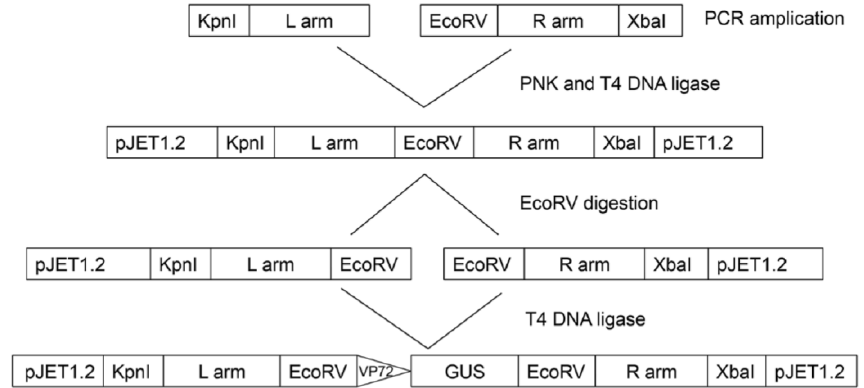
Figure 2. Schematic representation of the methodology used to generate the deletion plasmid vector. For the deletion of the A104R gene from the genome of Ba71V isolate, a plasmid vector p ∆ A104R_GUS containing the B646L (p72) promoter and GUS gene flanked by the homology arms of the A104R gene (L arm and R arm) was constructed.